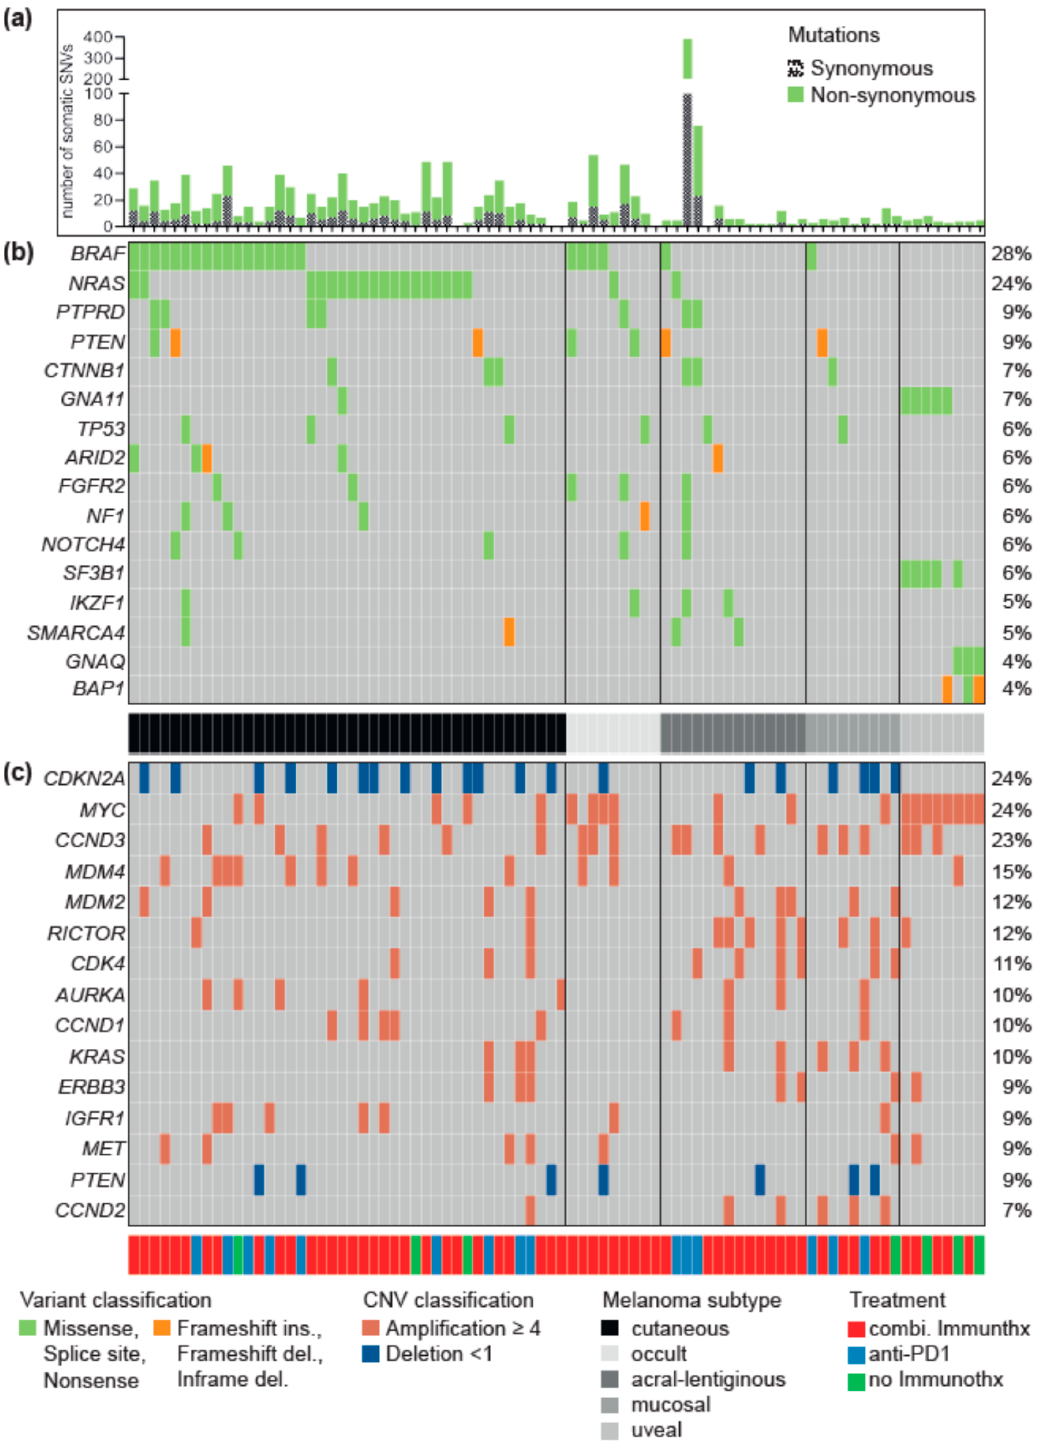
Figure 1. Oncoplot of the most frequently mutated genes with driver mutations. Figure 1 shows a summary of the most frequent driver mutations of the melanoma cohort based on the 275 genes contained in all 3 panel versions. The Oncoplot shows the patients in a horizontal orientation and the gene and the corresponding driver mutations per patient in the vertical orientation. The plot is divided into three parts, in the upper area ( a ) all somatic single nucleotide variants (SNVs) and small insertions and deletions (INDELs) per patient, including the synonymous variants, are shown. The middle